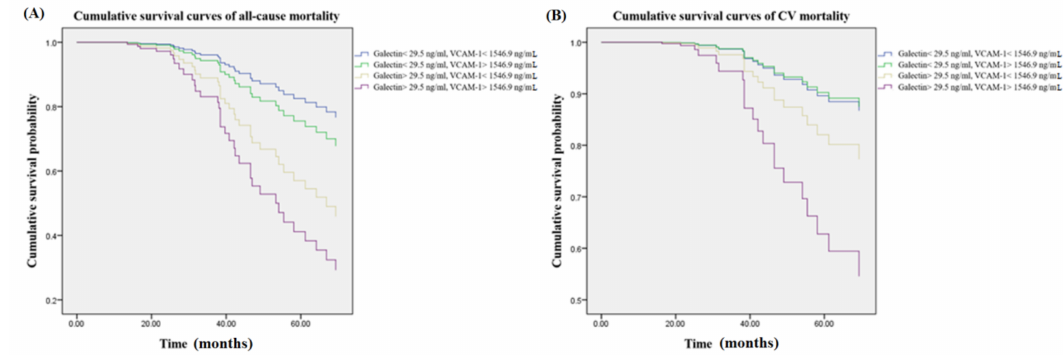
Figure 3. Cumulative survival curves of mortality risks with respect to different concentration groups of galectin-3 and VCAM-1 after adjusting for galectin-3, VCAM-1, albumin, age, CRP, nPCR, and smoking during follow-up. ( A ) The group with combined higher concentrations of galectin-3 (>29.5 ng/mL) and VCAM-1 (>1546.9 ng/mL) showed higher risks for all-cause mortality as compared to the reference group (galectin-3 < 29.5 ng/mL and VCAM-1 < 1546.9 ng/mL). ( B ) The group with combined higher concentrations of galectin-3 (>29.5 ng/mL) and VCAM-1 (>1546.9 ng/mL) showed greater CV mortality risks as compared to the reference group (galectin-3 < 29.5 ng/mL and VCAM-1 < 1546.9 ng/mL). The interaction analysis between serum galectin-3 and VCAM-1 remained statistically significant for all-cause mortality ( p < 0.01) and CV mortality ( p = 0.039), respectively. VCAM-1 = vascular cell adhesion molecule 1; CRP = C-reactive protein; nPCR = normalized protein catabolic